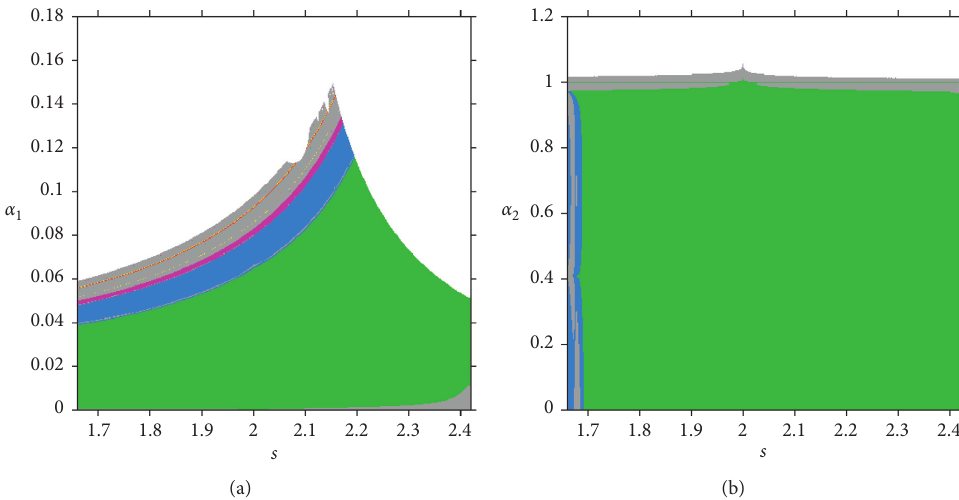
Figure 11: 2D bifurcation diagrams for periodic cycles. (a) 2D bifurcation with respect to α